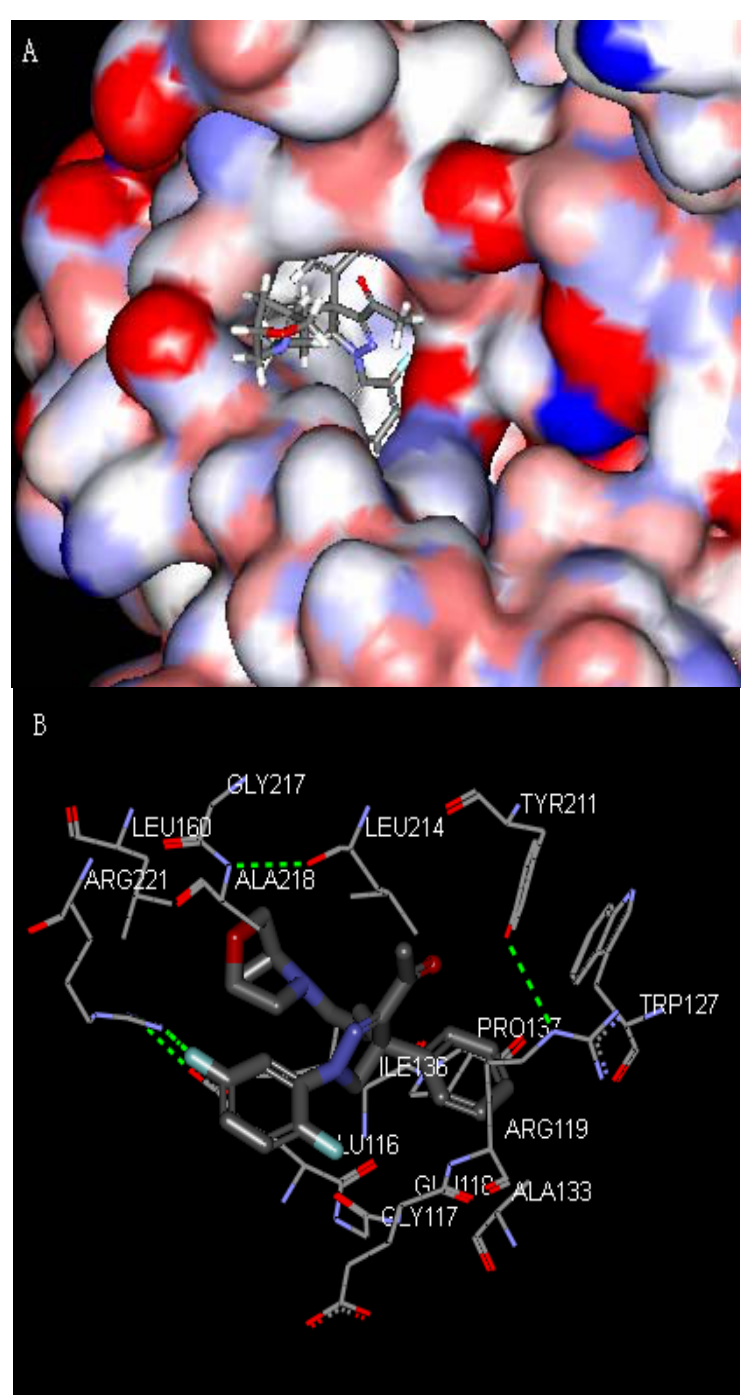
Figure 2. ( A ) Surface diagram showing the positions of the 1,4-diaryl-4,5-dihydropyrazole (A ) in the pocket (PDB code: 2WOG); ( B ) Stereo plot showing 1,4-diaryl-4,5- 01 ) in the pocket (PDB code: 2WOG); ( C ) Overall of alignment of the dihydropyrazole (A 01 37 inhibitors obtained by the molecular